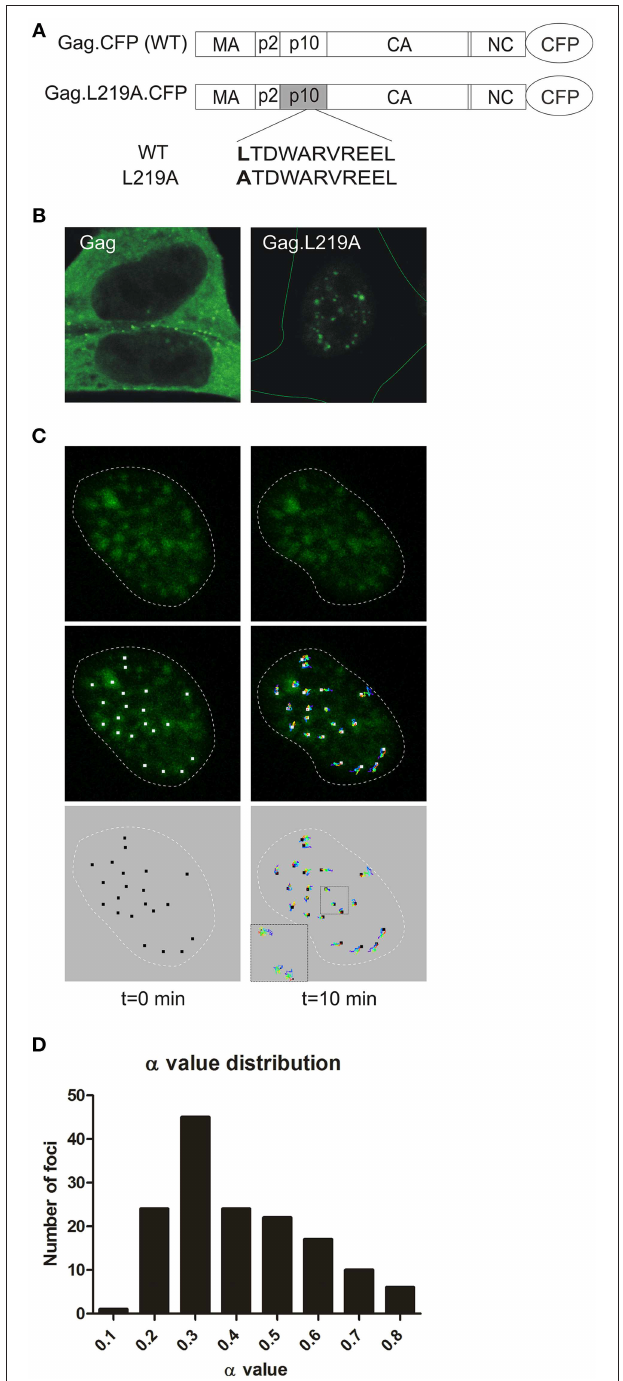
FIGURE 1 | Characterization of Gag.L219A nuclear foci. (A) Schematics of the CFP-tagged wild-type RSV Gag protein (top) and the Gag.L219A nuclear export mutant (bottom), with leucine 219 in the p10 domain mutated to alanine. (B) Confocal micrographs of fluorescent protein-tagged wild-type Gag (left panel) and Gag.L219A (right panel) in QT6 cells. On the right hand image, the entire cell is outlined with a thin green line. (C) QT6 cells expressing Gag.L219A-CFP were imaged using time-lapse 3D confocal microscopy. A series of single optical slices through the nucleus were captured every 8s